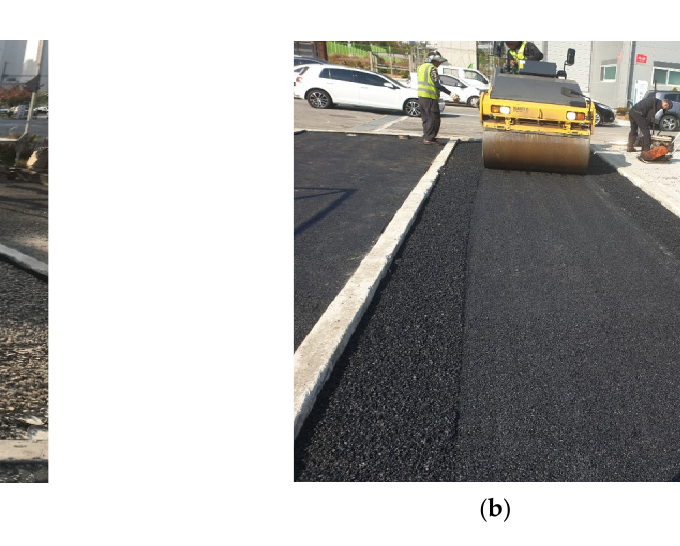
Figure 2. Compact asphalt pavement layer: ( a ) base layer; ( b ) asphalt layer.